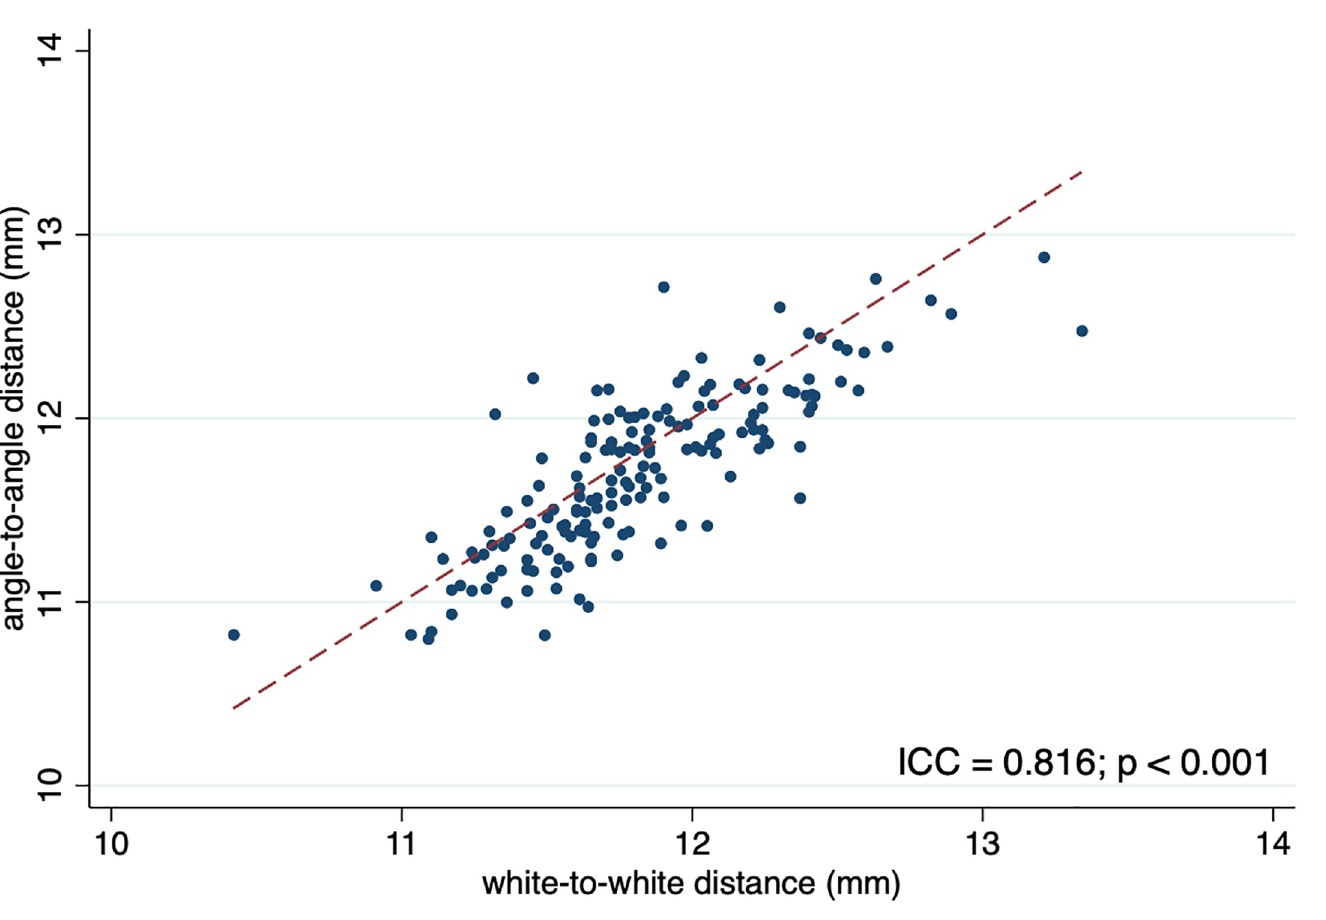
Fig 3. Scatter plot of angle-to-angle distance with respect to white-to-white distance. ICC, intraclass correlation coefficient; dashed line indicates the equality line.